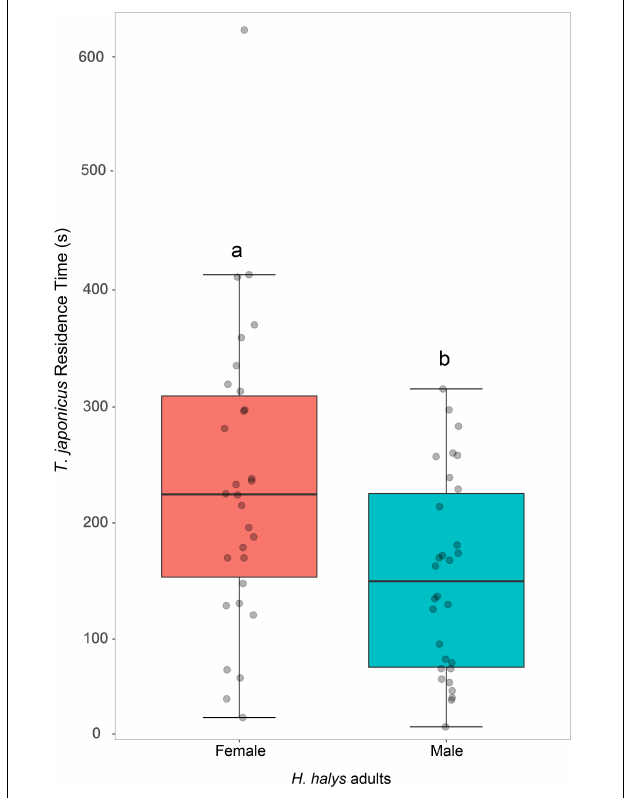
FIGURE 1 | Response of Trissolcus japonicus females to substrate treated with traces of freshly killed Halyomorpha halys females (red box) or males (blue box). Bold horizontal lines show medians, boxes contain the 25 th –50 th percentiles, whiskers show the upper and lower quartiles and points represent individual replicates. Different letters indicate statistically significant difference ( P < 0.05,